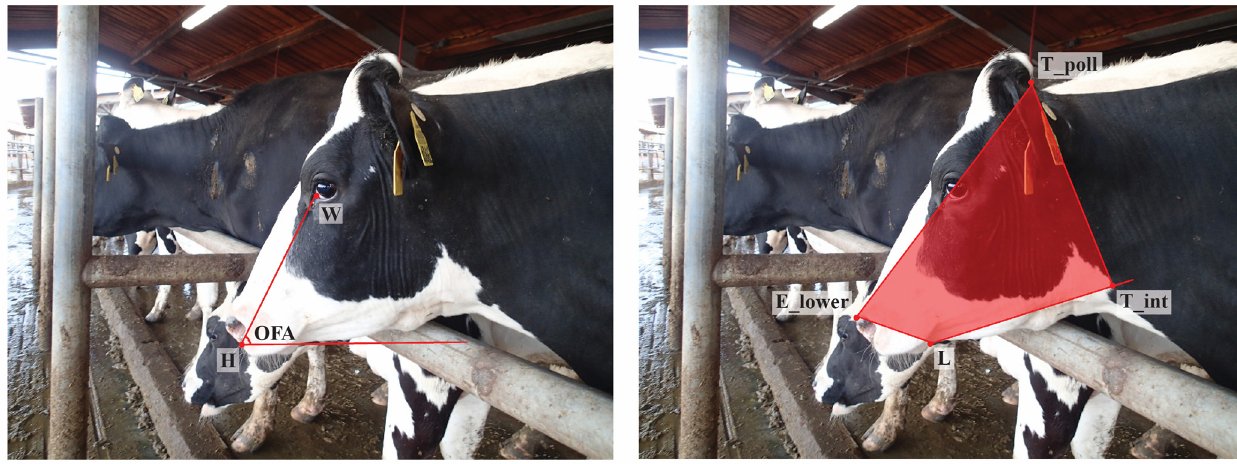
Figure 2. Measures of image quality: Overall Face Angle ( left ) and Frame:Face Ratio ( right ).